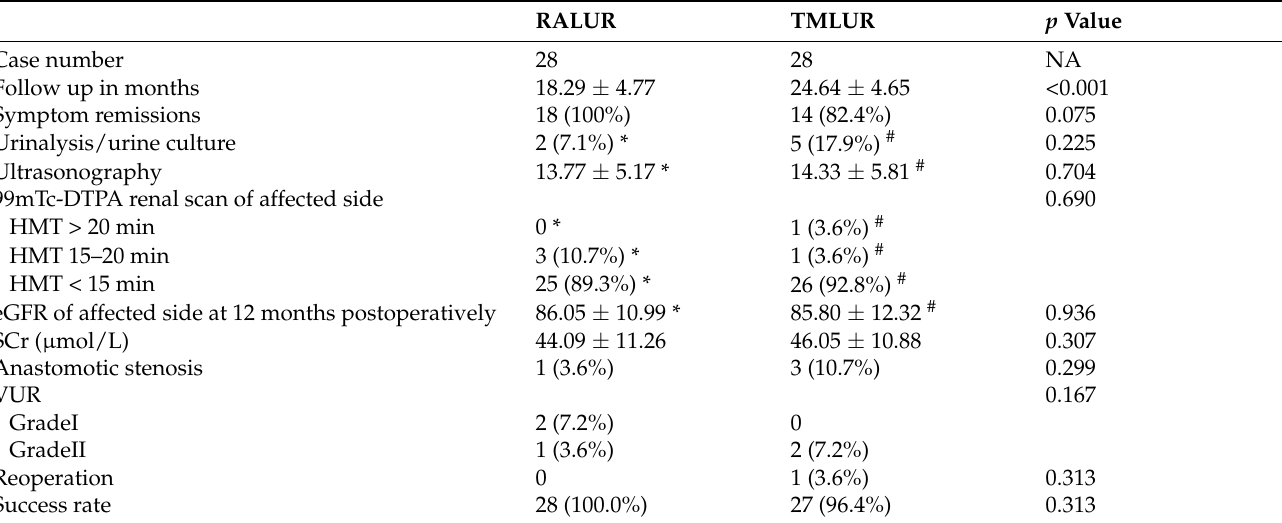
Table 3. Follow-up data in RALUR and TMLUR groups. RALUR